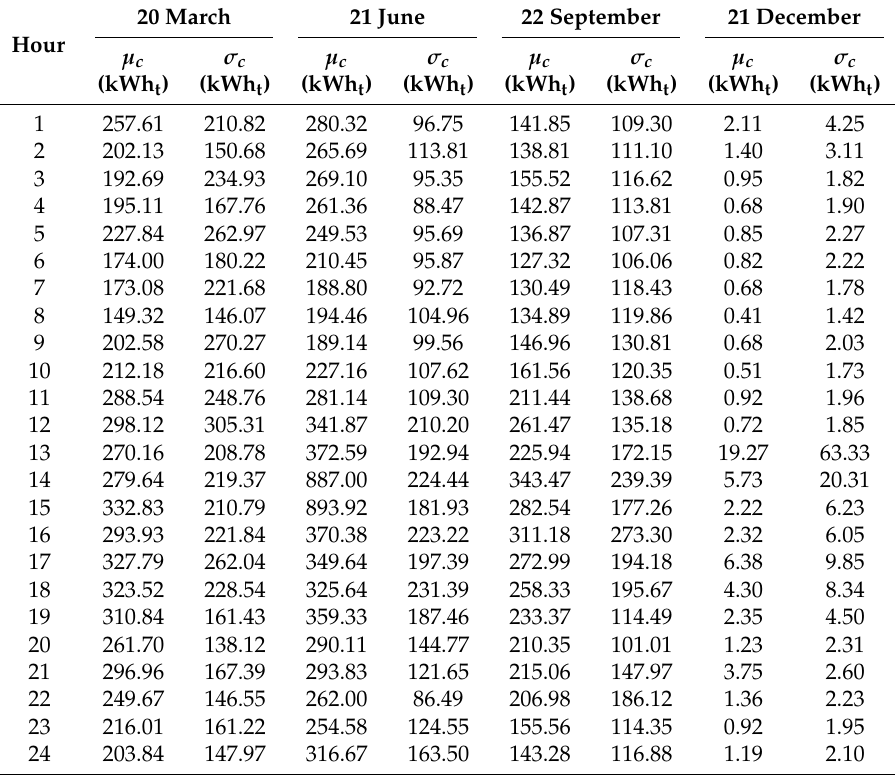
Table A3. Cooling load parameters (mean and standard deviation) on four different days.